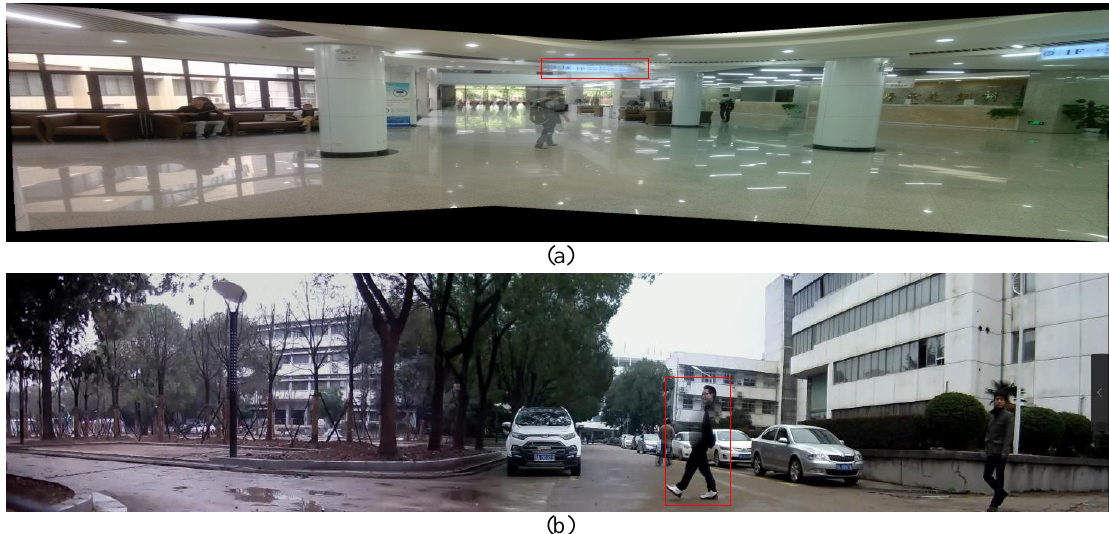
Figure 1. The main reason for ghosting comes from misalignment error. Here we show two types of ghosting in red boxes: ( a ) ghosting caused by using a global projective warping; ( b ) ghosting caused by persons moving across seams.